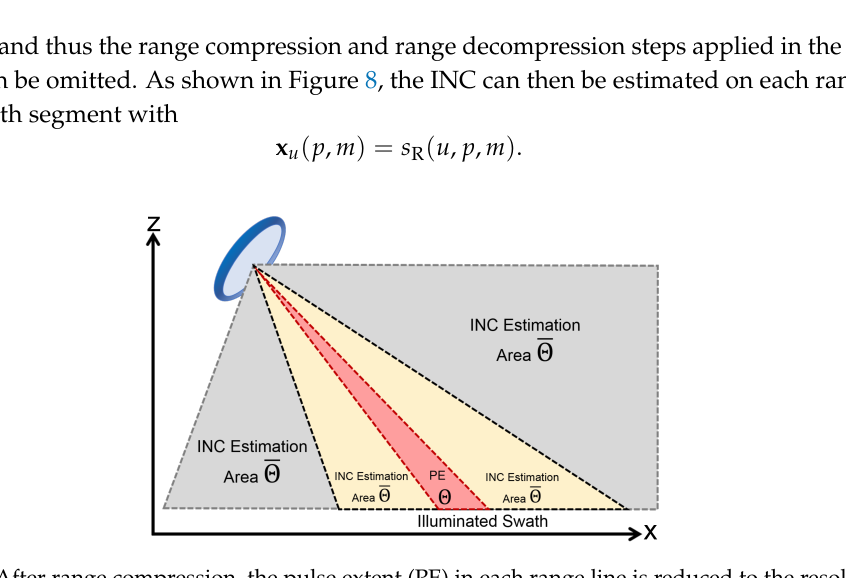
Figure 7. After range compression, the pulse extent (PE) in each range line is reduced to the resolution of the Impulse Response Function (IRF).